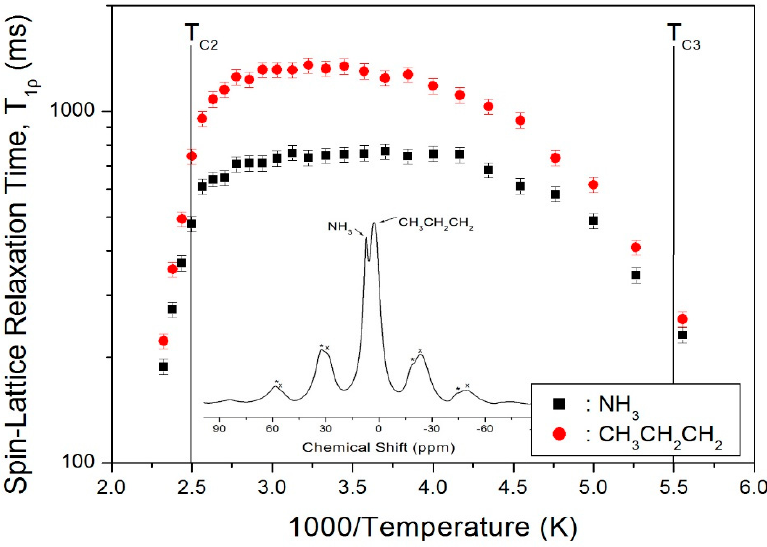
Figure 3. T 1 ρ values of 1 H in the C 3 H 7 and NH 3 groups vs. 1000/T. Inset: 1 H MAS NMR spectrum of (C 3 H 7 NH 3 ) 2 CdCl 4 at 300 K. The spinning sidebands are marked with crosses and asterisks.